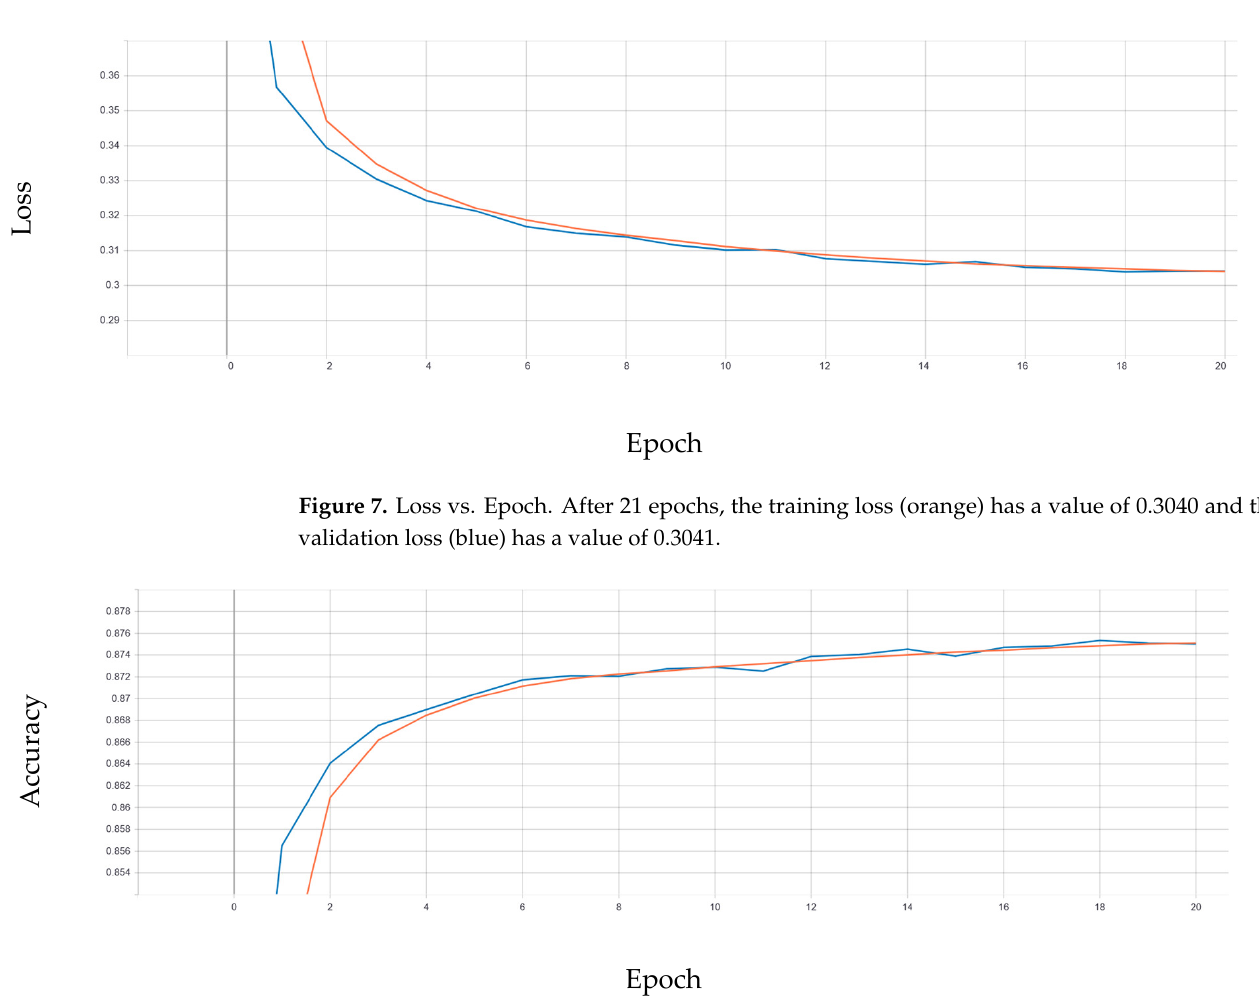
Figure 8. Accuracy vs. Epoch. After 21 epochs, the training accuracy (orange) has a value of 0.8751 and the validation accuracy (blue) has a value of 0.8750.